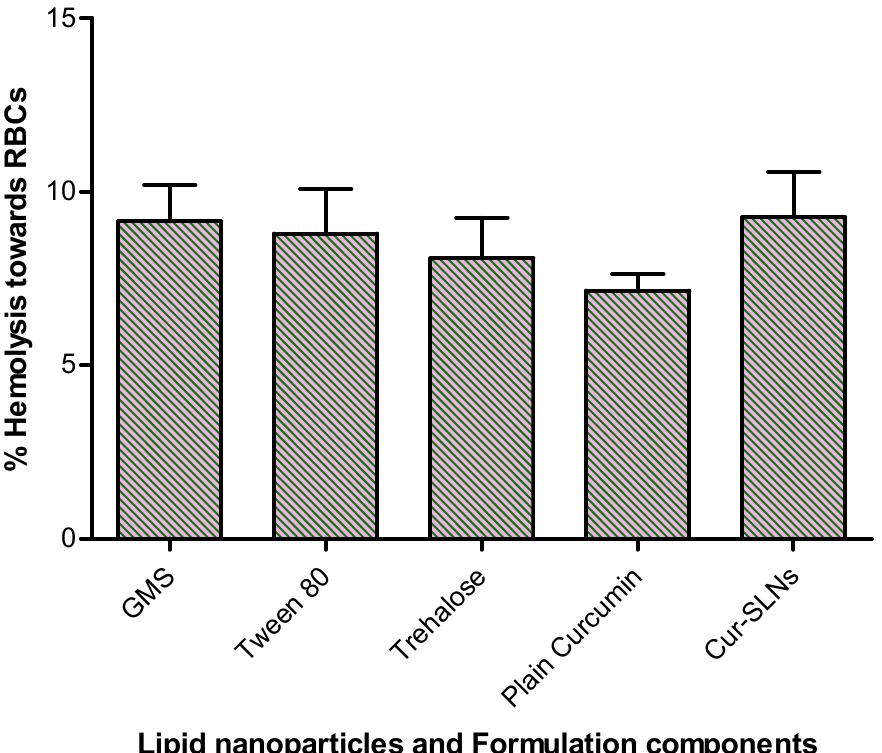
Figure 4. % hemolysis caused by Cur-SLNs, plain curcumin, formulation components (lipid: GMS, surfactant: tween 80, cryoprotectant: trehalose). Table 2. Effect of cryoprotectant on particle size, PI, ZP, EE and DL measured after reconstitution in double distilled water.